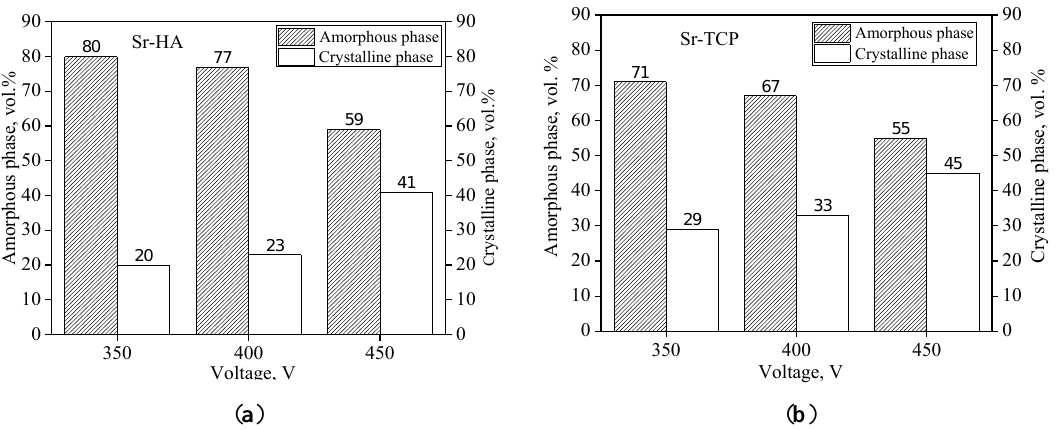
Figure 5. Diagrams of the ratio of amorphous and crystalline phases in the Sr-HA ( a ) and Sr-TCP ( b ) coatings.